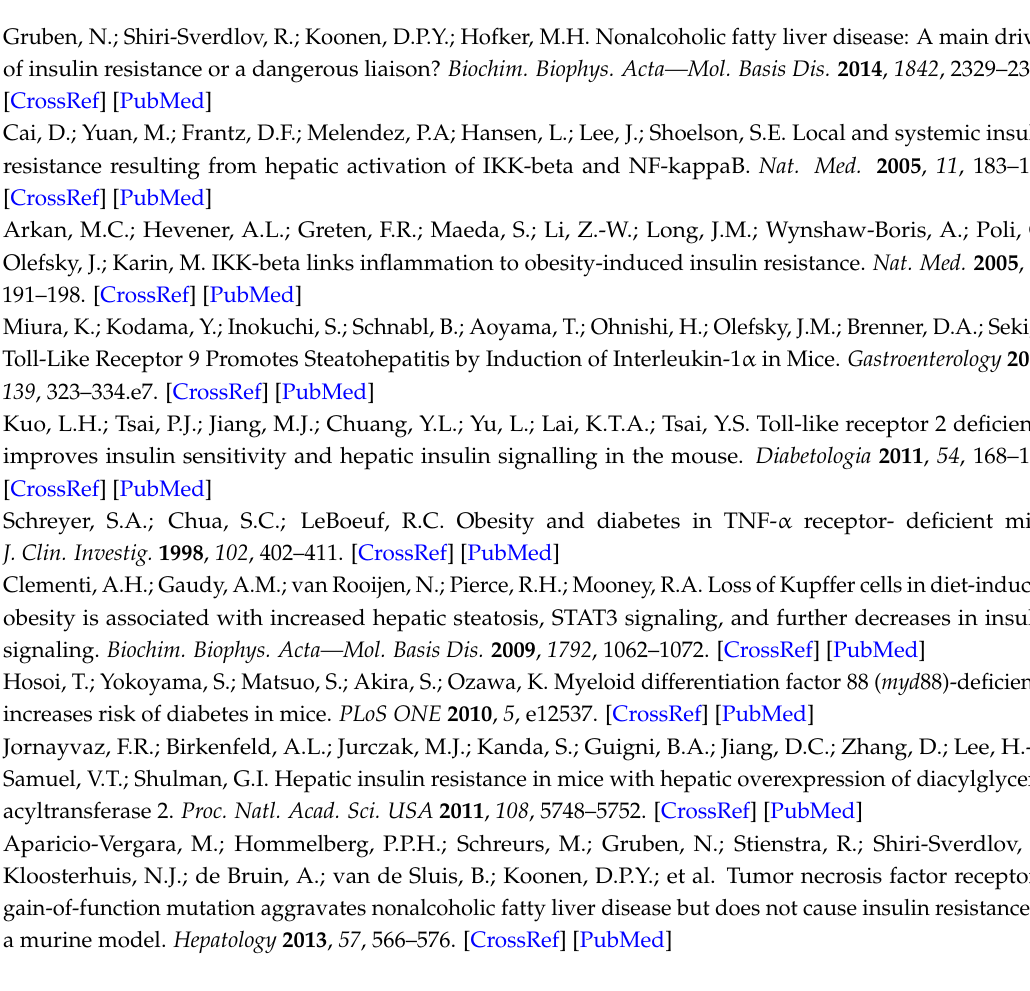
Table S1: Primers used for RT-PCR., Table S2: Zoometric parameters of LDLR − / − mice exposed to four different dietary